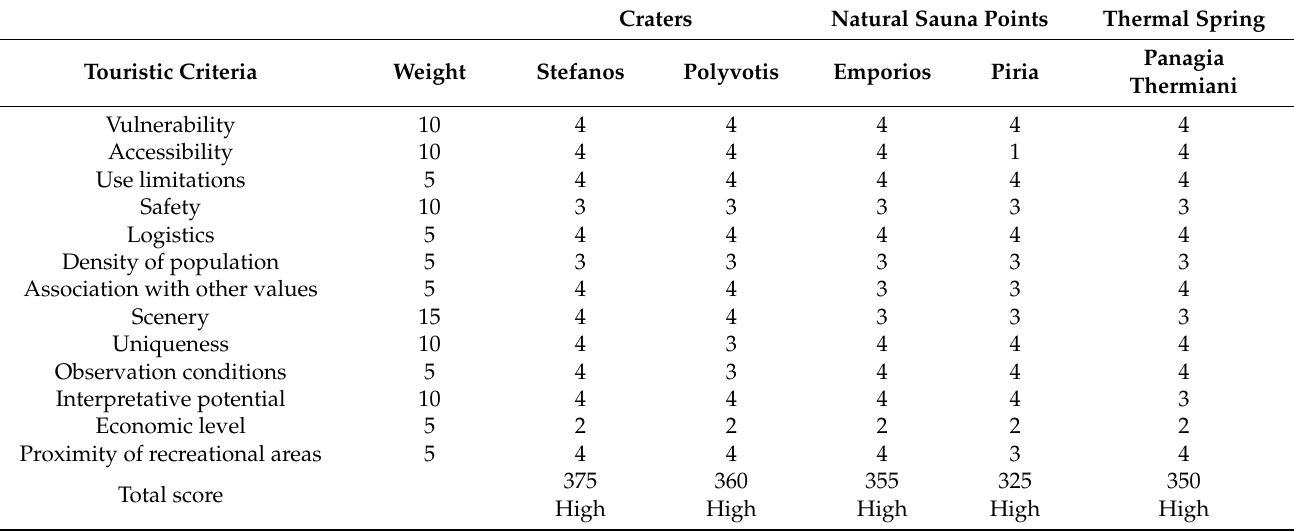
Table 4. Quantitative evaluation of geosites for tourism potential use (PTU).